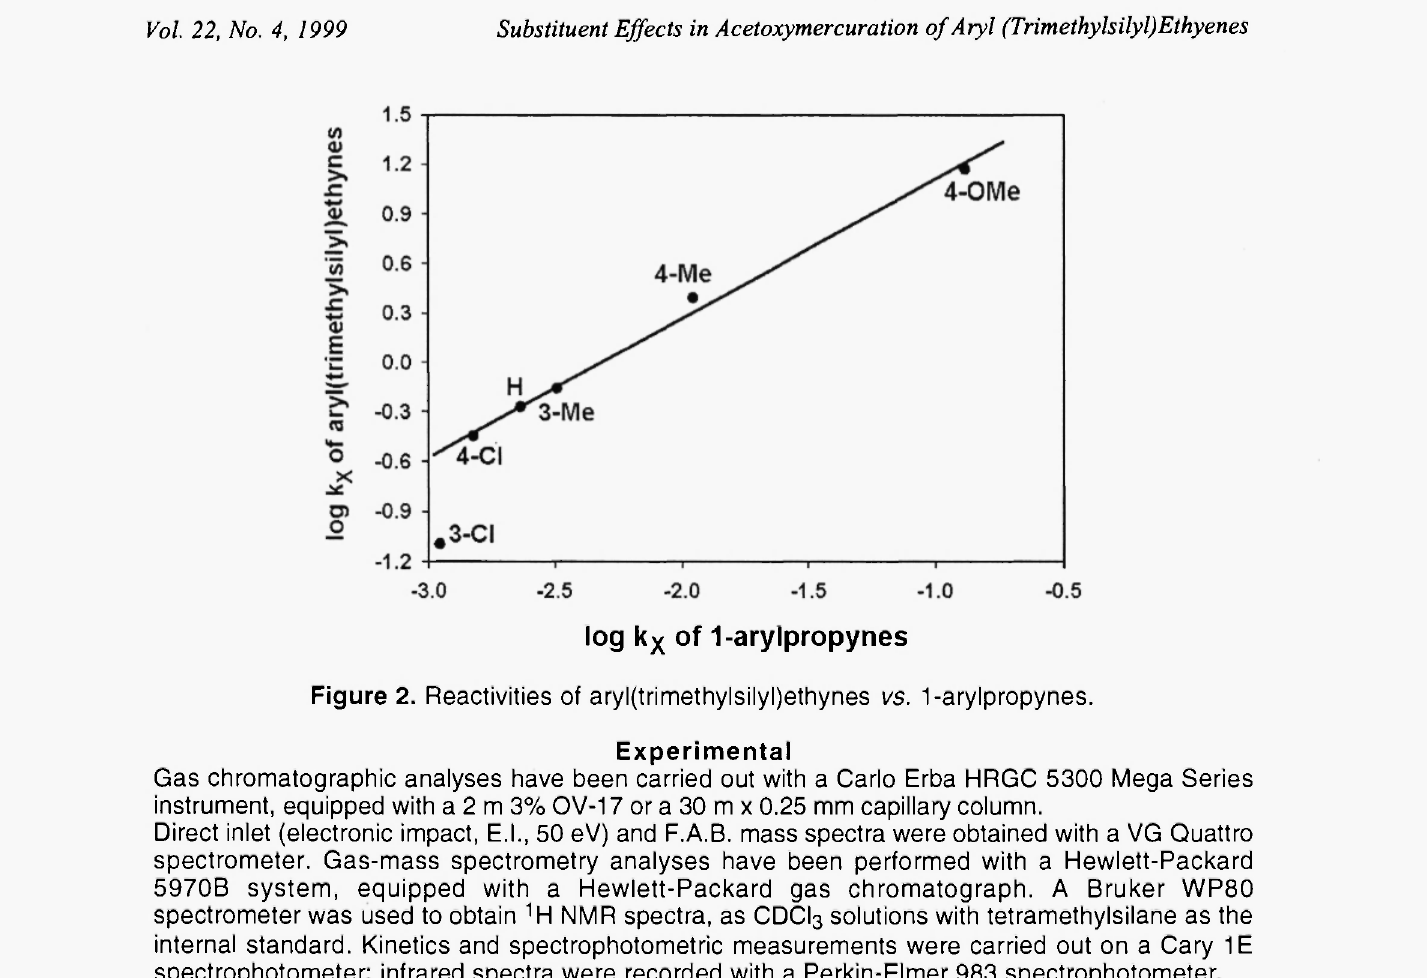
Figure 2. Reactivities of aryl(trimethylsilyl)ethynes vs. 1-arylpropynes.